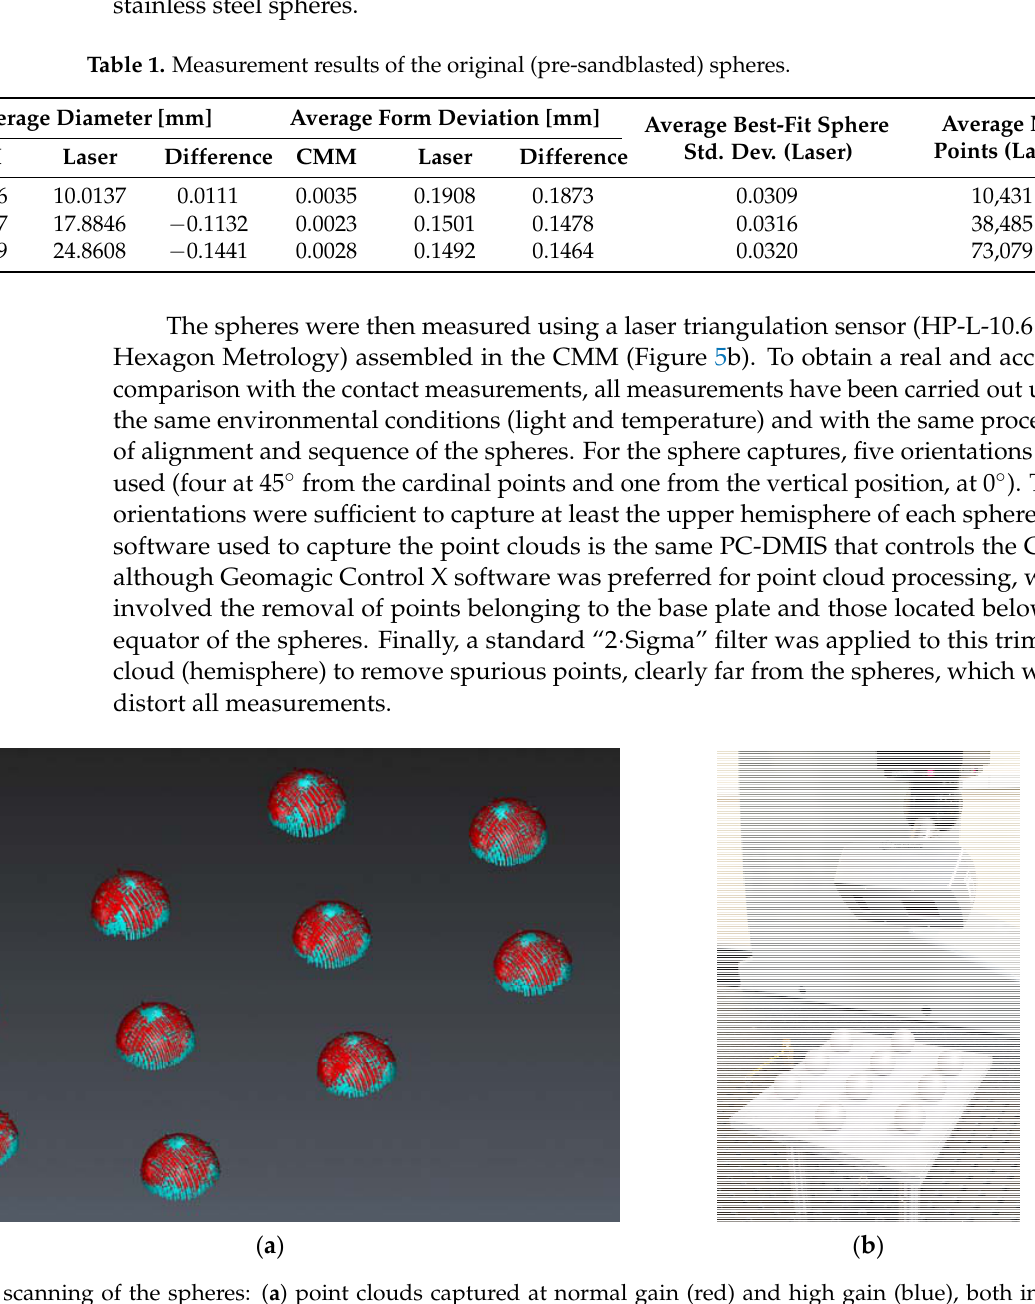
Figure 5. Laser scanning of the spheres: ( a ) point clouds captured at normal gain (red) and high gain (blue), both in pre-sanded state; ( b ) general view of the HP-L-10.6 laser sensor scanning at 45°.